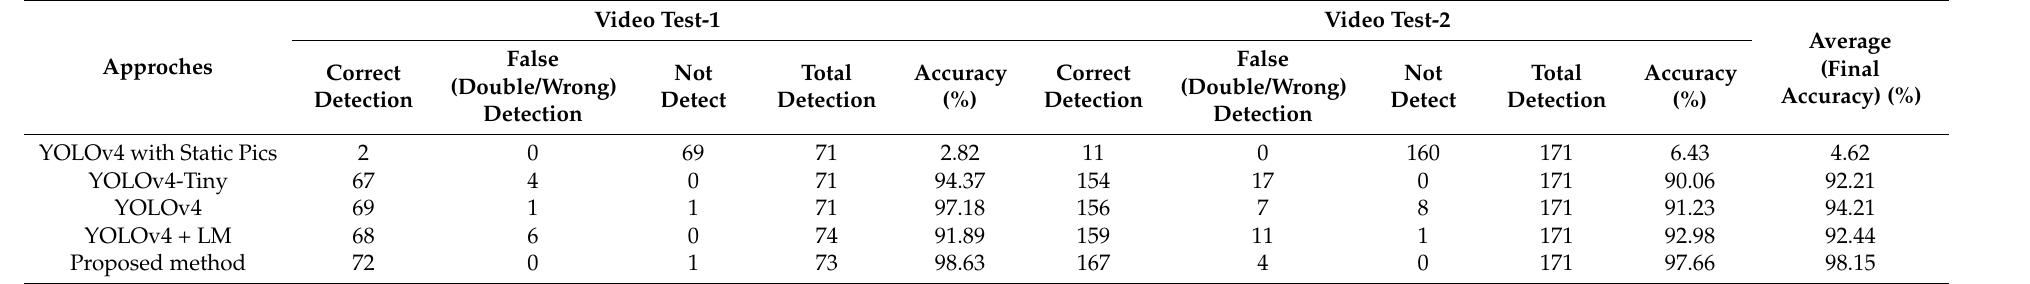
Table 5. Experimental results (accuracy).